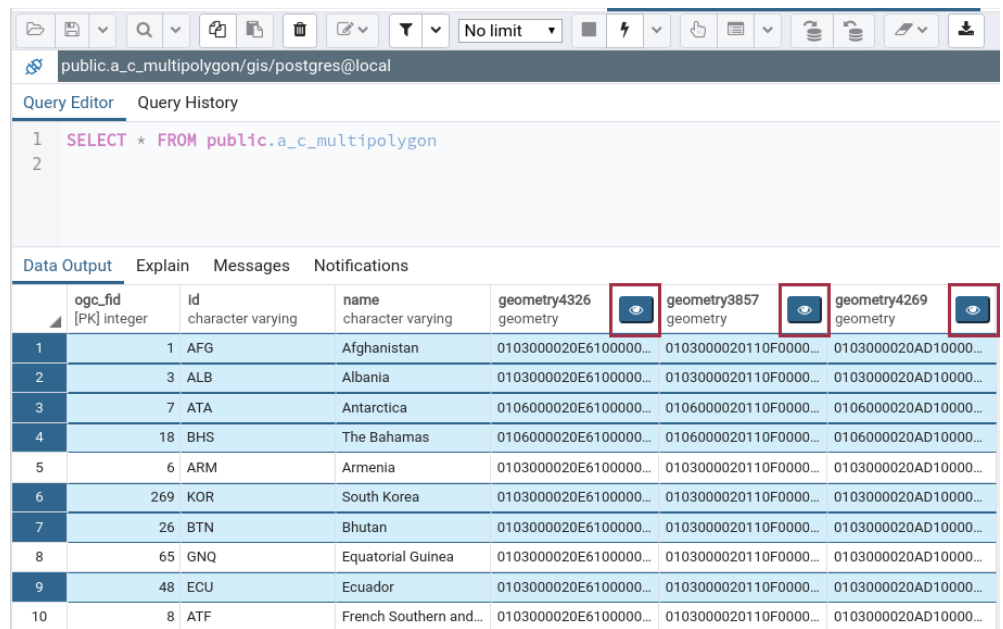
Figure 2. The “view” button in the geometry column header